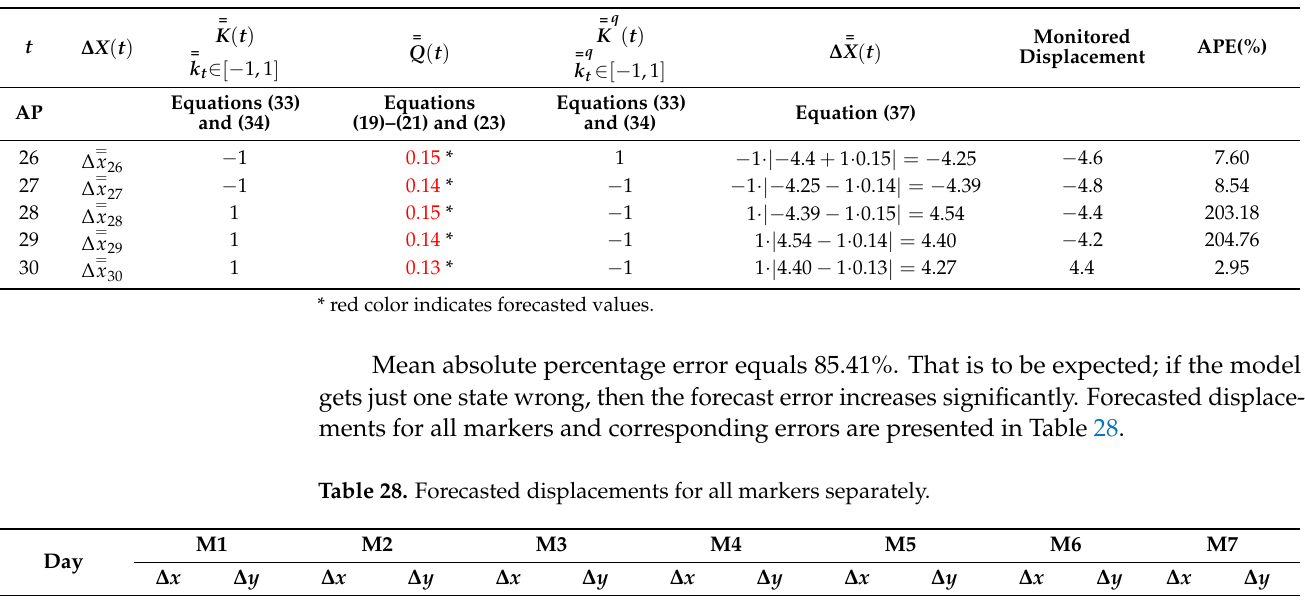
Table 27. Forecasted displacements of marker M4 along x -axis.